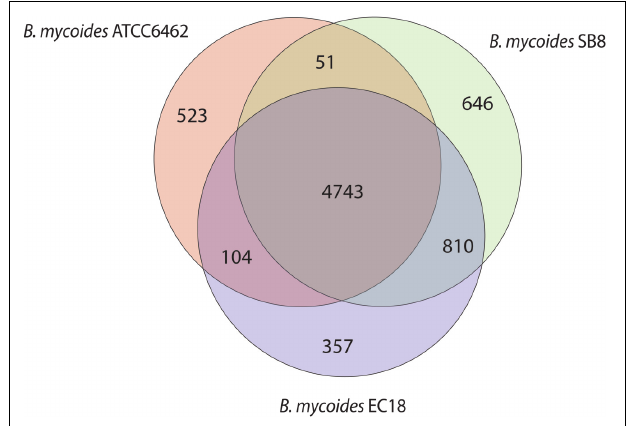
FIGURE 2 | Venn diagram showing the core genome and the genes specific of the B. mycoides strain ATCC 6462, EC18, and SB8.